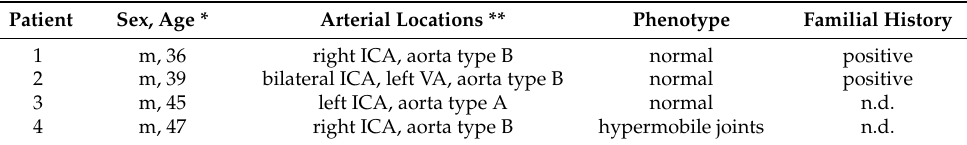
Table 1. Patient characteristics and clinical findings.